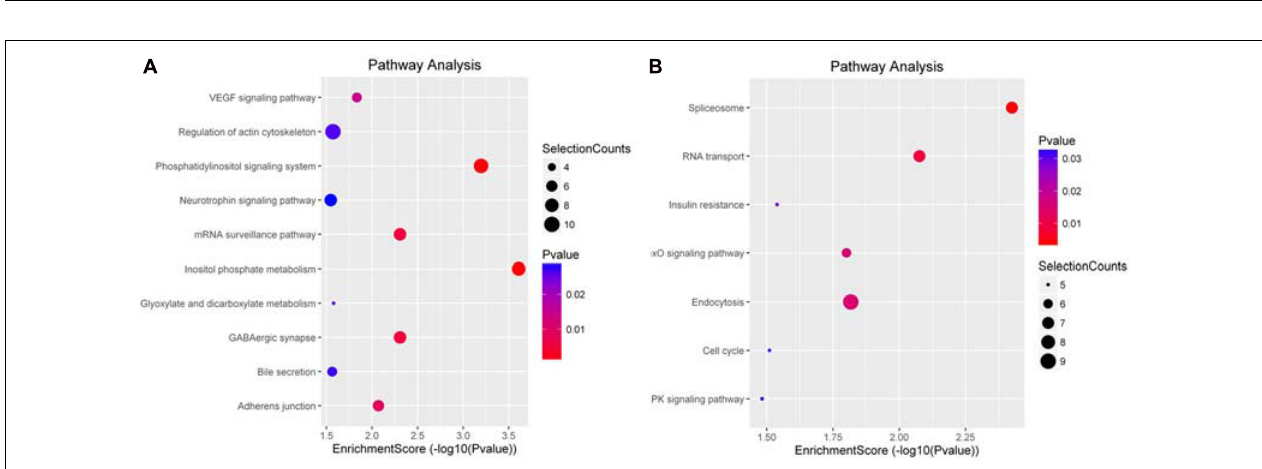
Frontiers in Genetics |